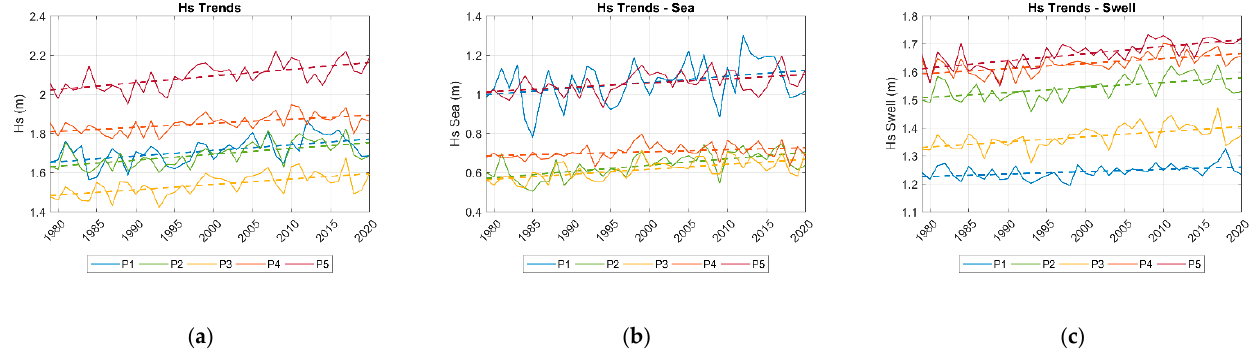
𝑠𝑤 𝑠𝑠 ( b ), and 𝐻 ( c ), for each key point selected